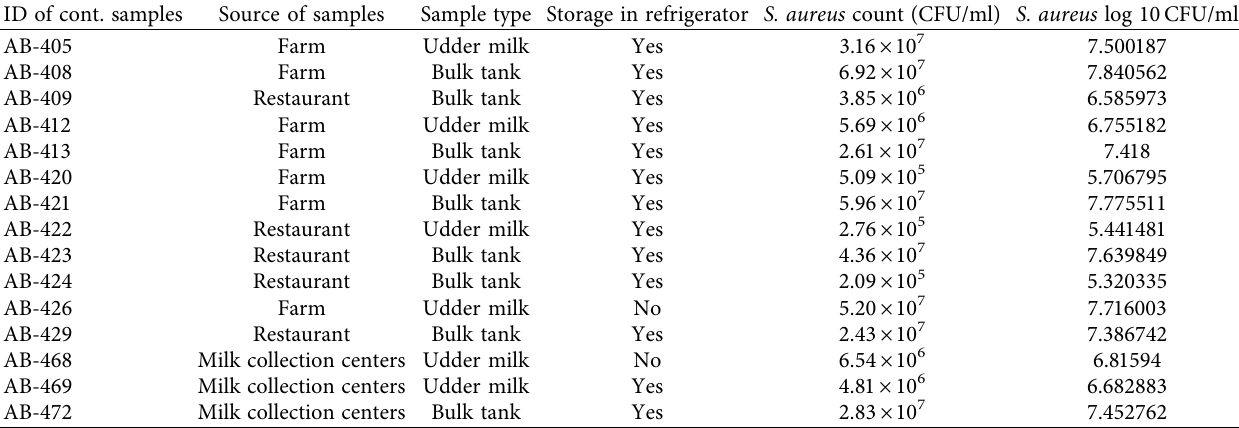
Table 6: S. aureus counts in log10 CFU/ml by sample source, sample type, and storage condition. ID of cont. samples